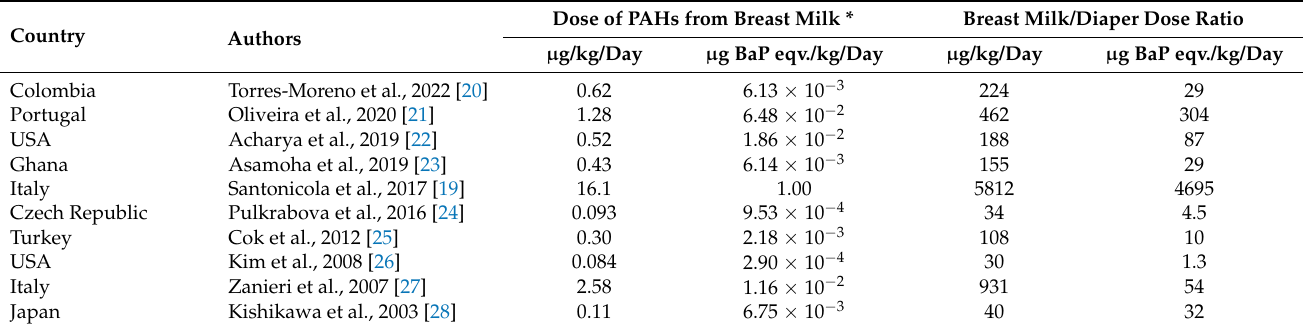
Table 7. Comparison of the BaP-equivalent daily dose of PAHs from breast milk of non-smoking women with that from